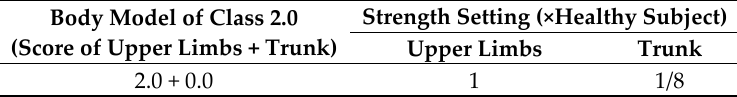
Table 1. This table shows the strength setting by muscular